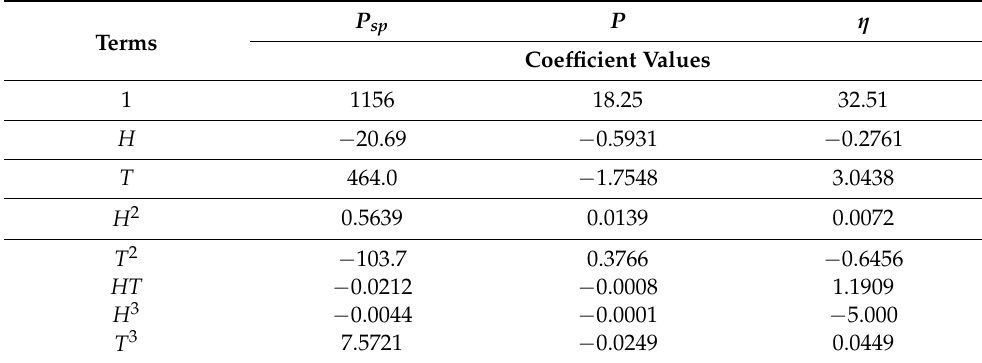
Table 3. RSM function terms and the corresponding coefficient values.